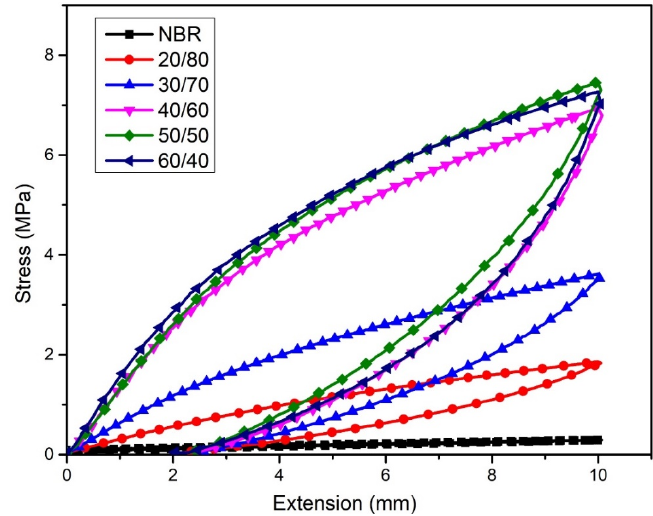
Figure 5. Stress relaxation curve of various WLF/NBR ratios.